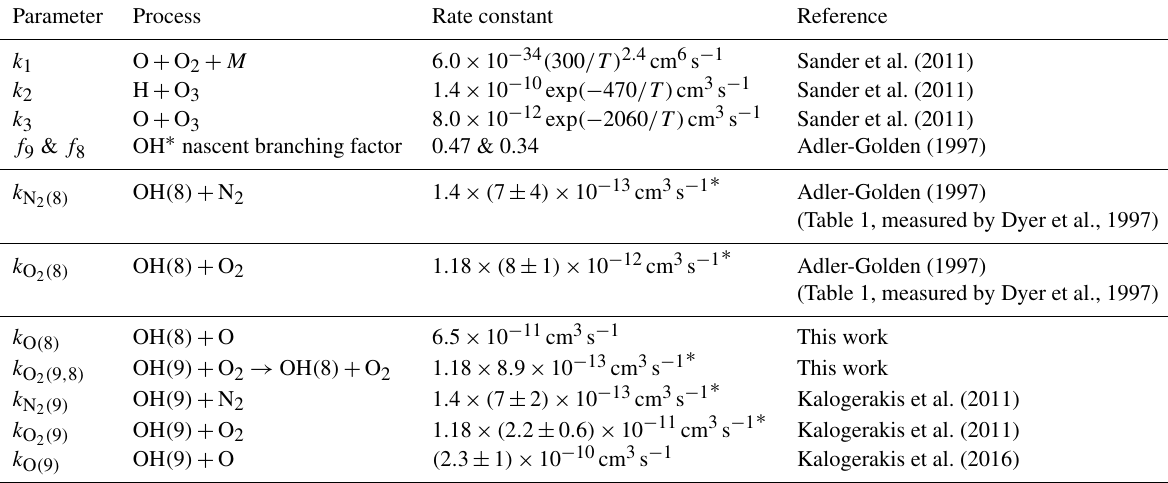
Table 1. OH airglow modeling parameters used in this study, where k 1 to k 3 represent the chemical reaction rate coefficient; f 9 and f 8 refer to the OH ∗ nascent production branching ratio for vibrational level v = 9 or 8; and k N OH ∗ radicals by N 2 , O 2 and O.